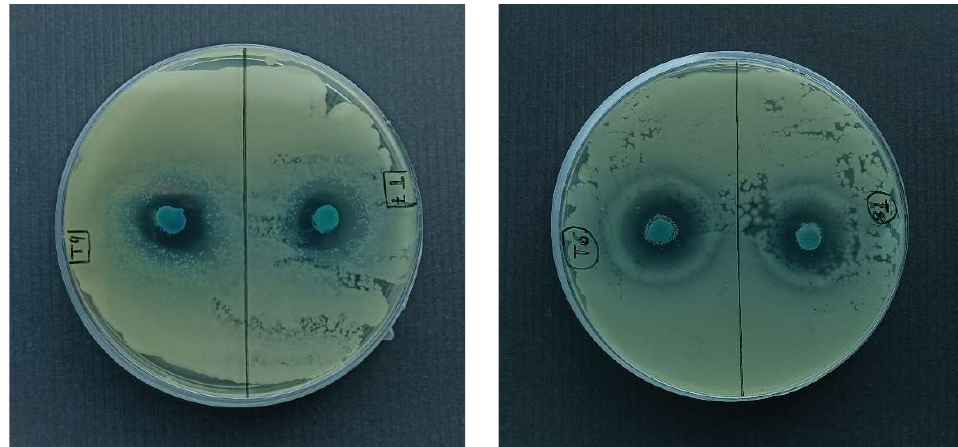
Figure 7. POM agar diffusion test against E. coli : Na 2 Cu 4 [W 12 O 40 (OH) 2 ]·22H 2 O (T6),